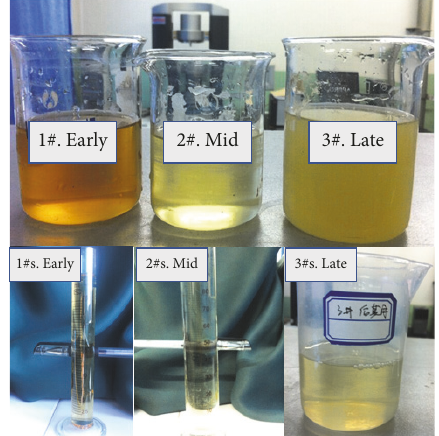
Figure 5: Flowback fluid samples (1#–3#) after filtering and decol- oring treatments.